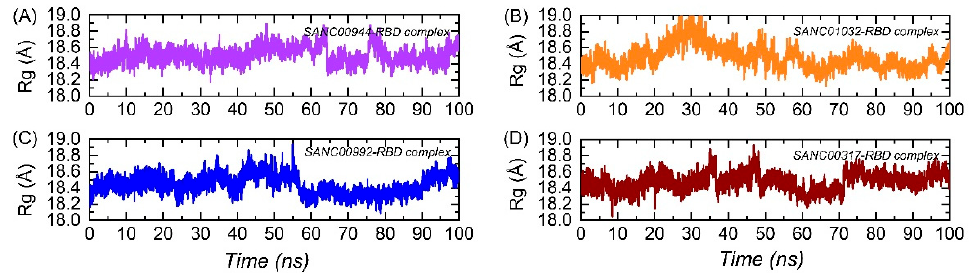
Figure 8. Structural compactness analysis of the top hits in complex with the RBD: ( A ) the Rg of the SANC00944–RBD complex; ( B ) the Rg of the SANC01032–RBD complex; ( C ) the Rg of the SANC00992–RBD complex; ( D ) the Rg of the SANC00317–RBD complex.